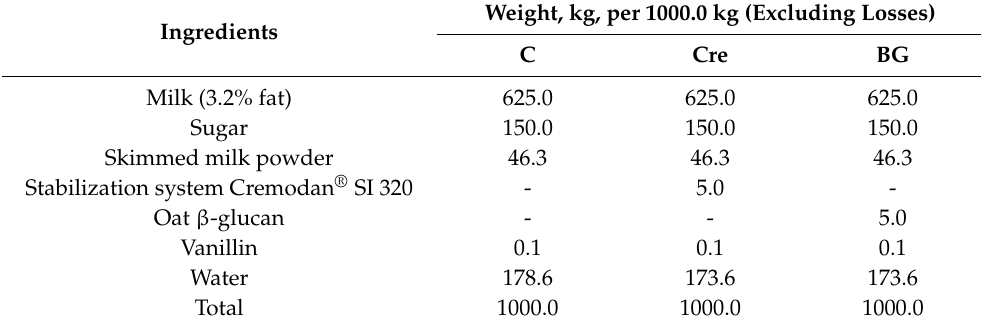
Table 6. The composition of low-fat milky ice cream (2%